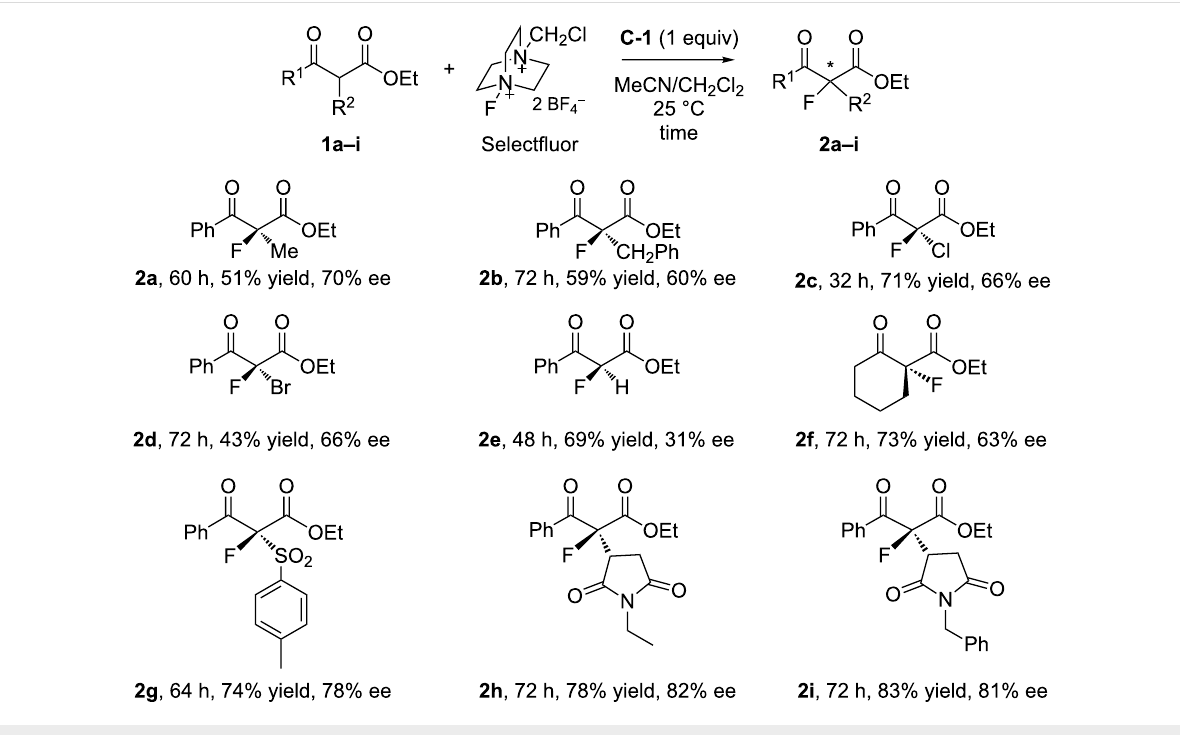
The scope of fluorous quinine ester C-1- mediated fluorination was evaluated by carrying out the reactions with a number of α -substituted ethyl benzoylacetates 1a–e and 1g–i as well as ethyl 2-cyclohexanonecarboxylate ( 1f ). Results summarized in Figure 3 indicate that benzoylacetates bearing R 2 such as Me, PhCH 2 , Cl, and Br gave fluorination products 2a–d in 43–71% yields and 60–70% ee. The nonsubstituted benzoylacetate 1e gave product 2e in good yield 69% but low ee (31%). Ethyl 2-cyclohexanonecarboxylate ( 1f ) afforded product 2f in 73% yield and 63% ee. Reactions of ethyl benzoylacetates with bigger substitution groups, such as phenylsulfonyl and maleimide derivatives, were also attempted and gave products 2g – i in 74–83% yields and 78–81%